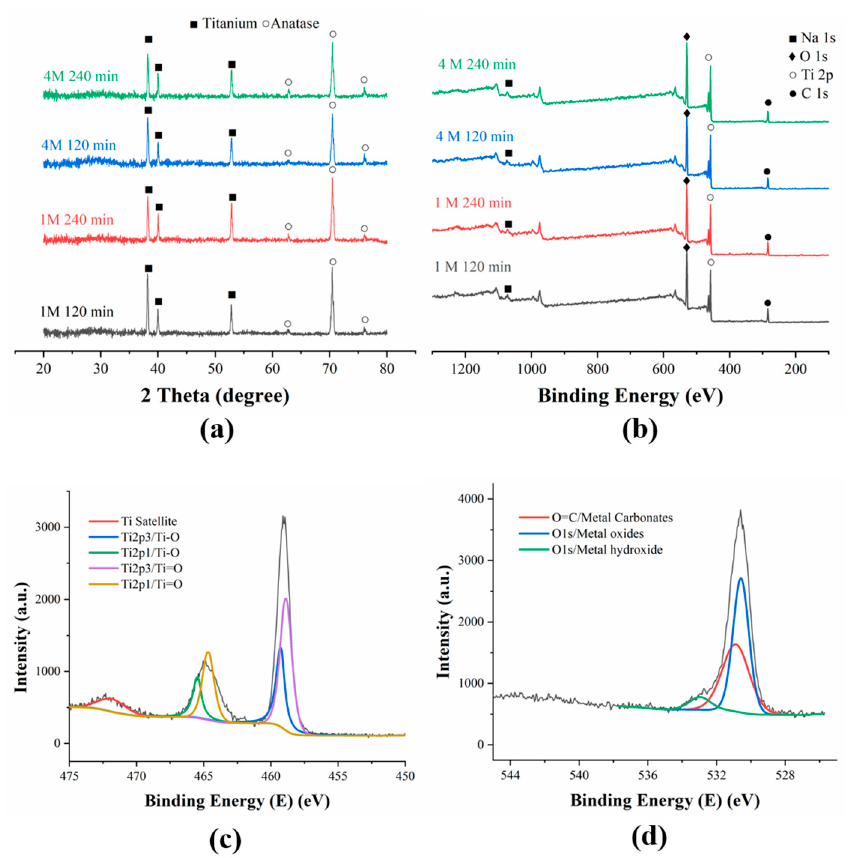
Figure 2. ( a ) XRD and ( b ) XPS pattern of the sensitive electrodes obtained using four typical fabri- cation parameters, ( c ) Ti 2p, and ( d ) O 1s deconvoluted core excitations for the electrode obtained using 1 M–120 min.